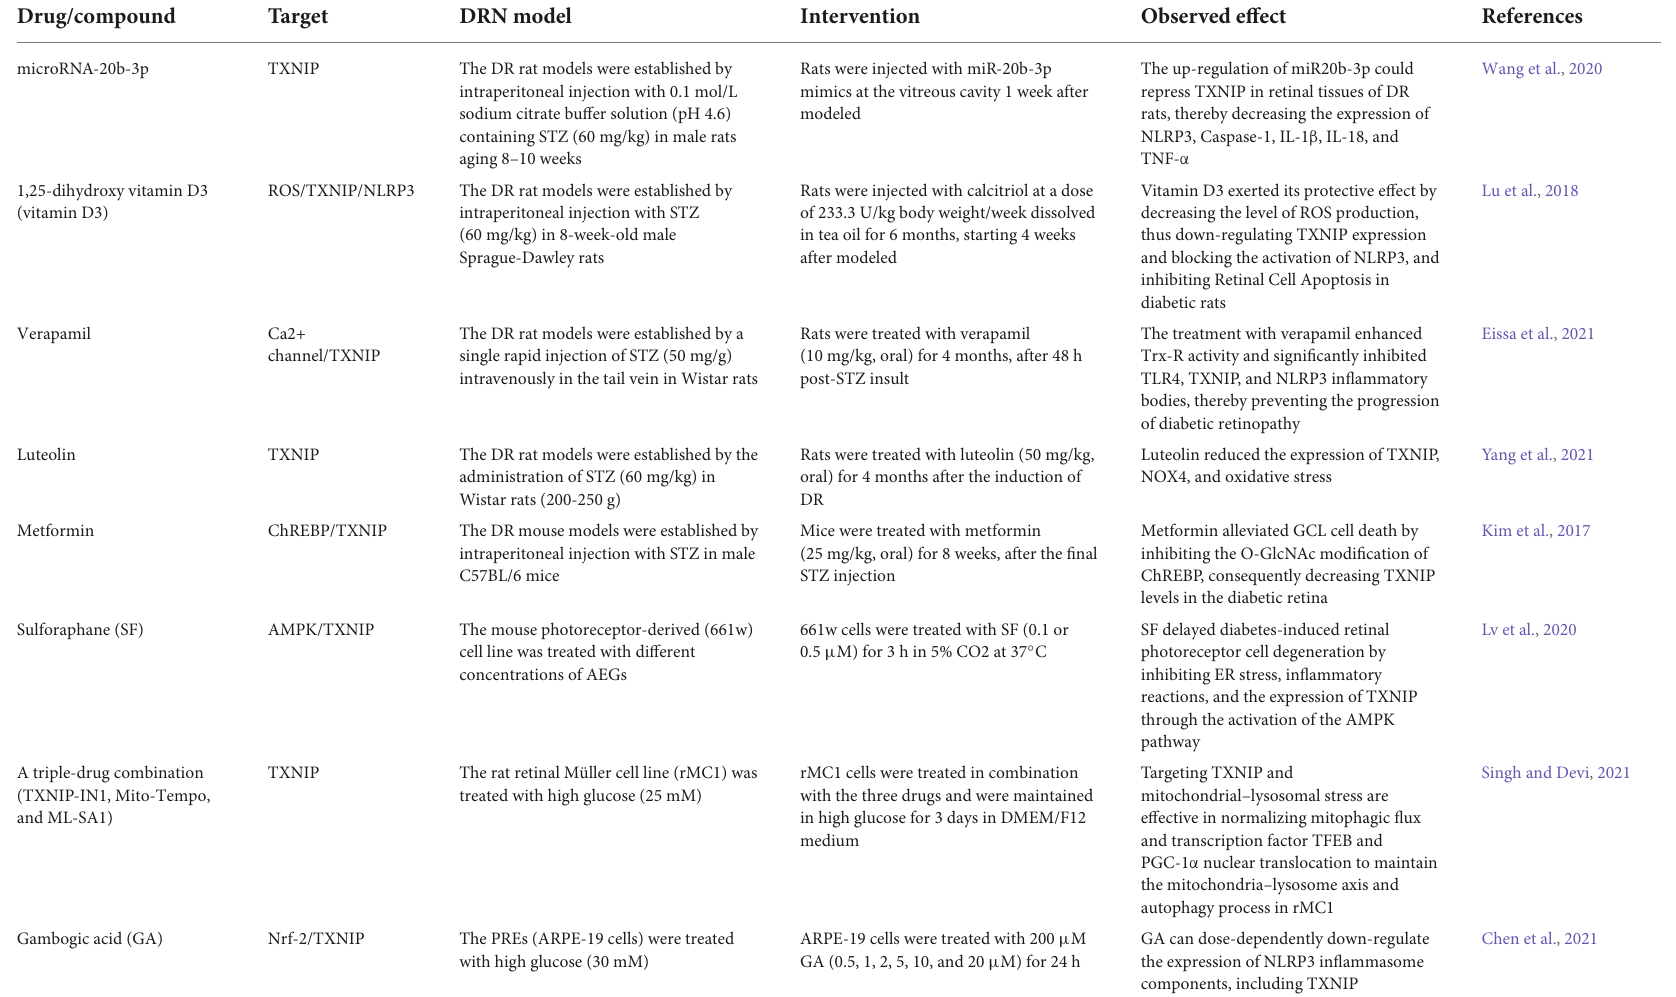
TABLE 1 List of drugs/compounds that have been identified to alleviate diabetic retinal neurodegeneration (DRN) in experimental